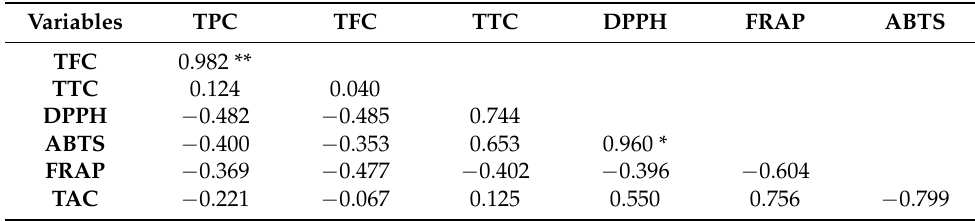
Table 2. Pearson’s correlation coefficients (r) for the relationships between antioxidant assays and phenolic